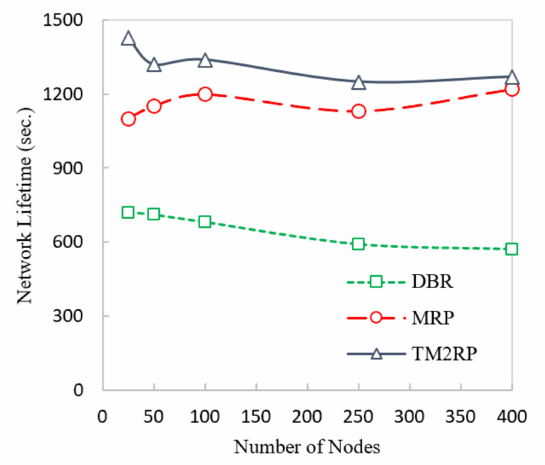
Figure 11. Comparison of underwater network lifetime with increasing number of nodes.